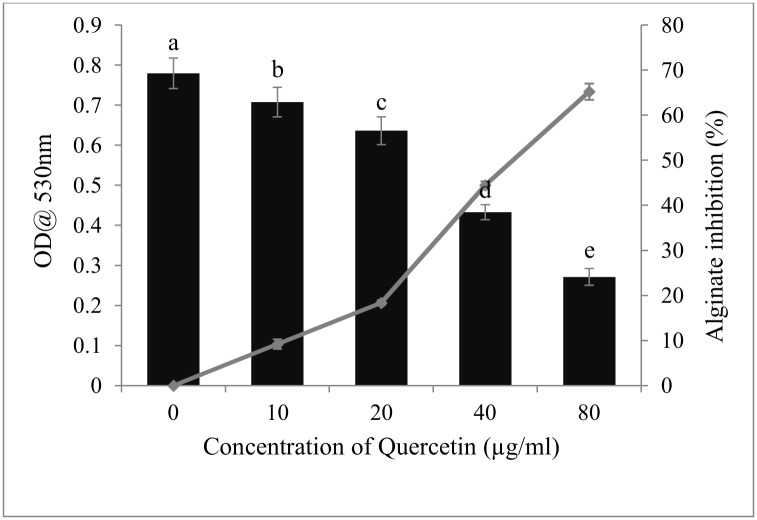
Inhibition of alginate production in P. aeruginosaby quercetin at different concentration(0–80).Mean values of triplicate independent experiments and SD are shown.